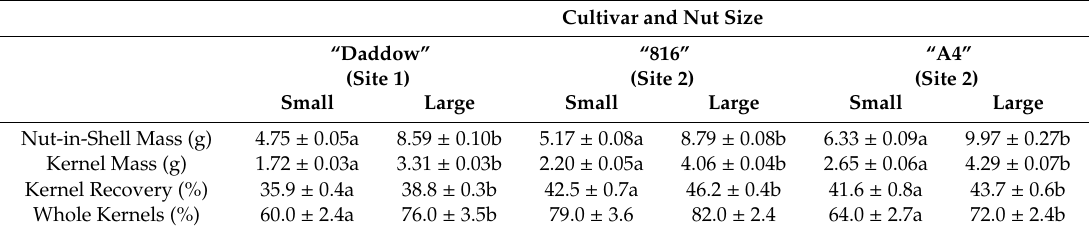
Table 1. Relationships between nut size, kernel size, kernel recovery, and incidence of whole kernels in macadamia cultivars, “Daddow”, “816” and “A4”, each sampled at one of two commercial orchard sites. Cultivar and Nut